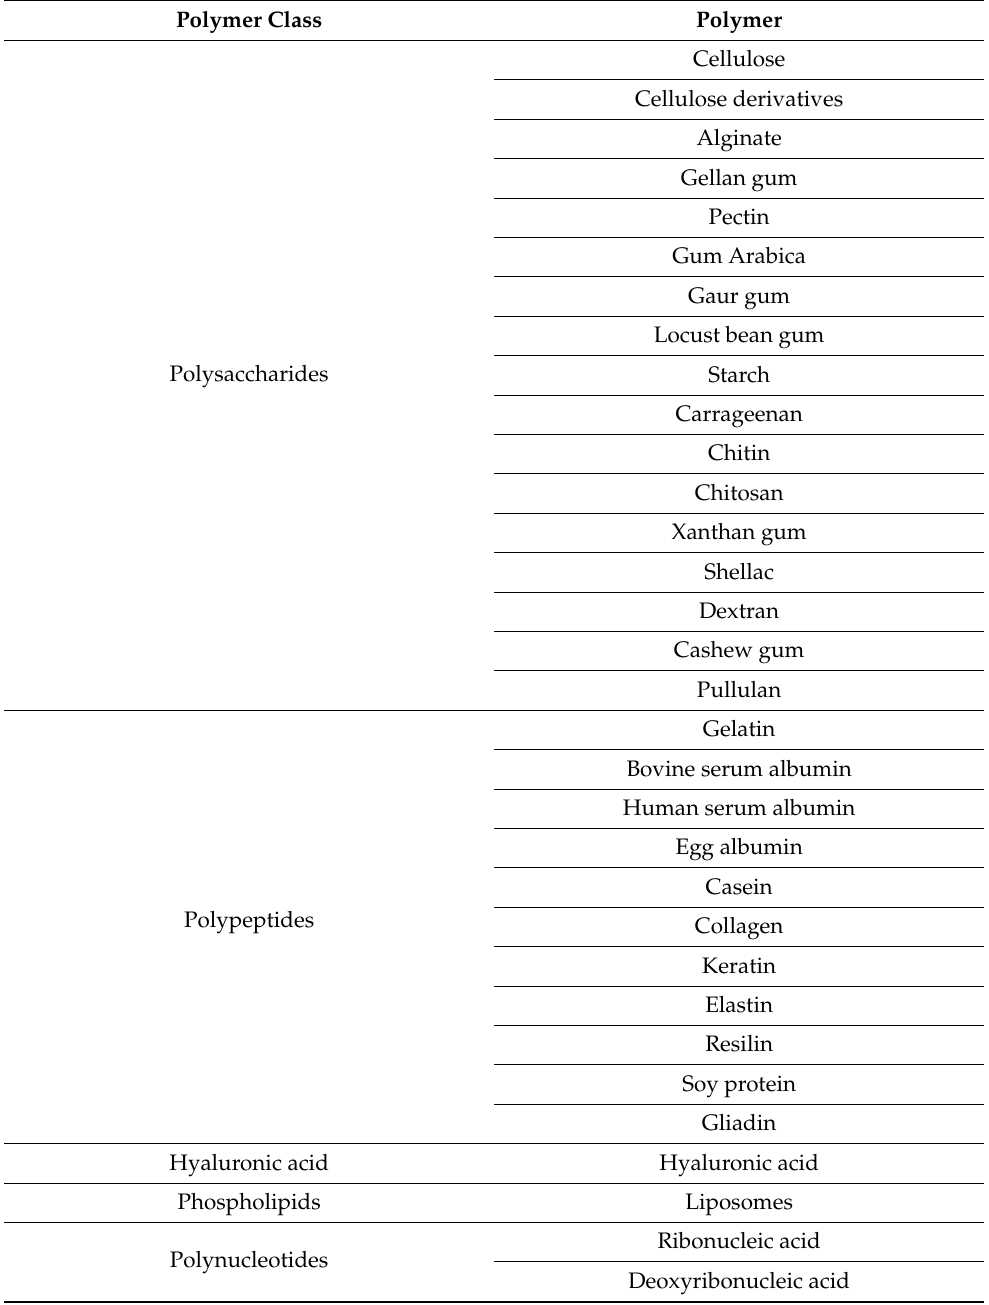
Table 1. List of natural polymers utilized to develop biomedical